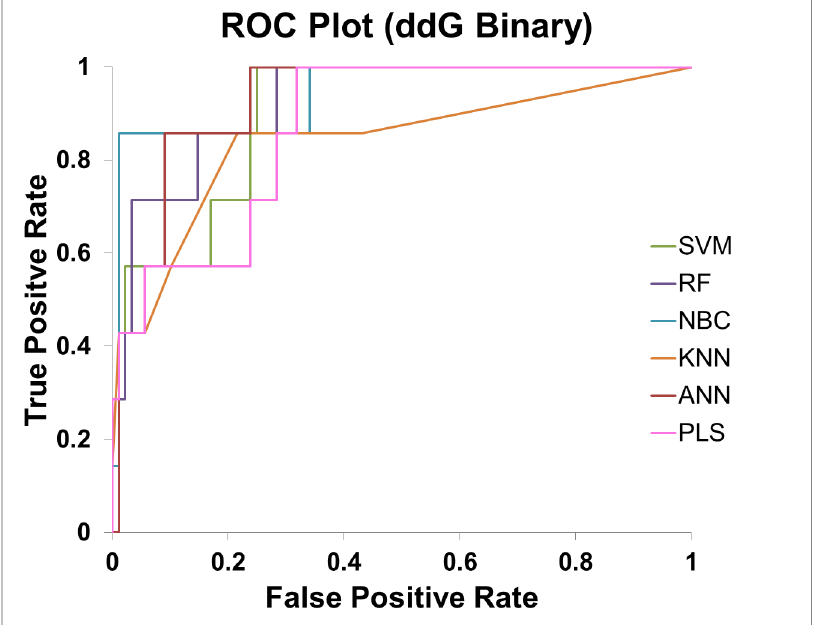
Fig 6. The ROC curves of ddG binary classification models for predicting the “ unseen ”